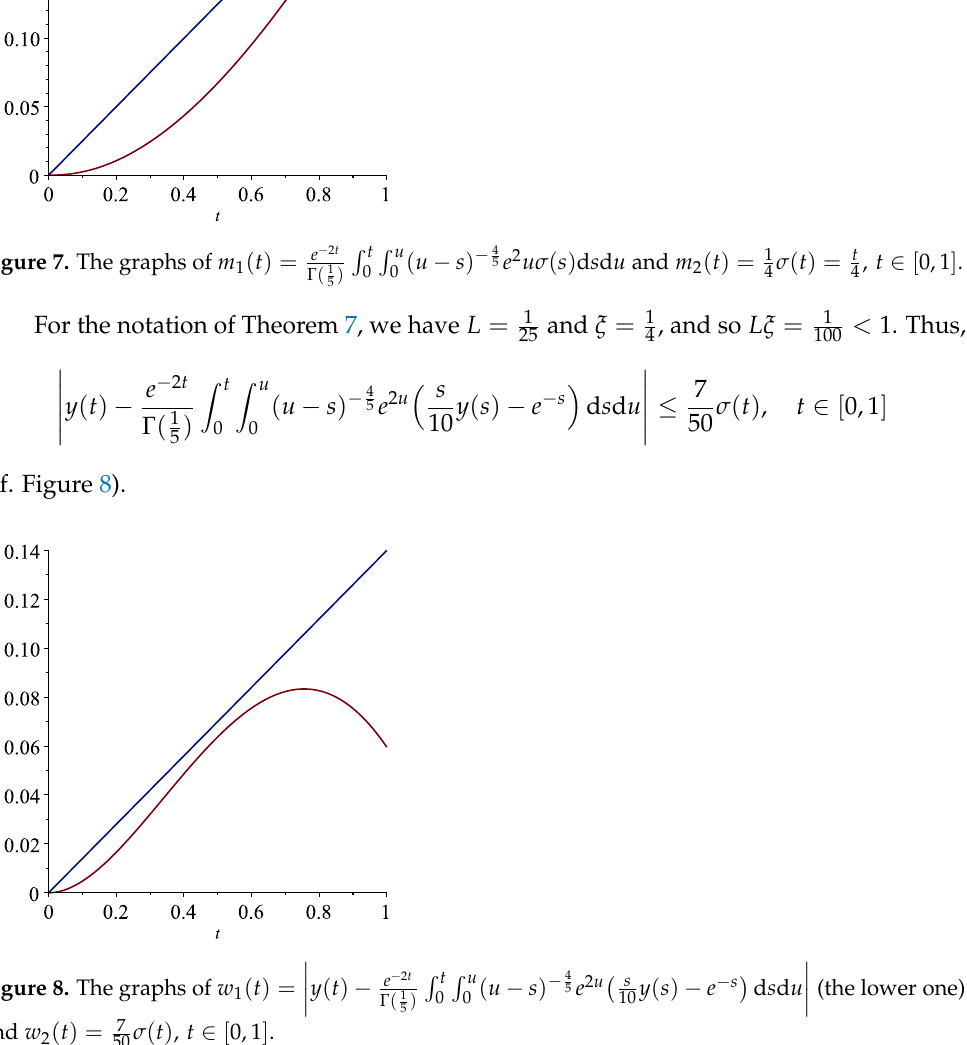
Figure 8. The graphs of w 1 ( t ) = σ ( t ) , t ∈ [ 0,1 ] and w 2 ( t ) = 7 50